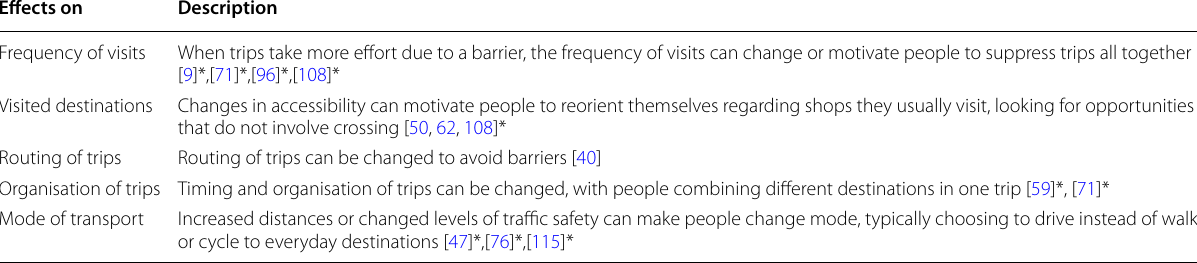
Table 7 Indirect barrier effects of traffic and transport